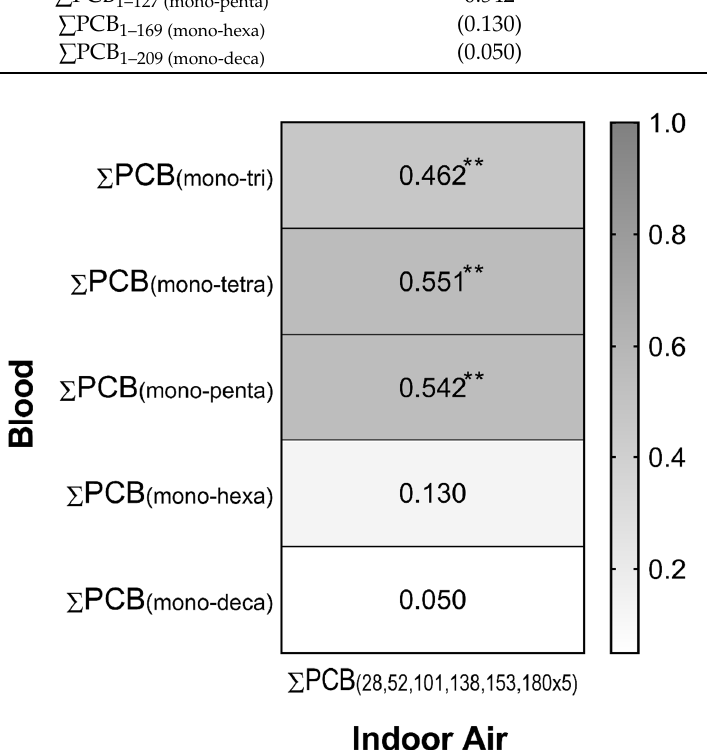
Figure 2. Heat map of correlation factors between PCBs in the indoor air and in the blood of the individuals ( n = 35); ** = p < 0.05.